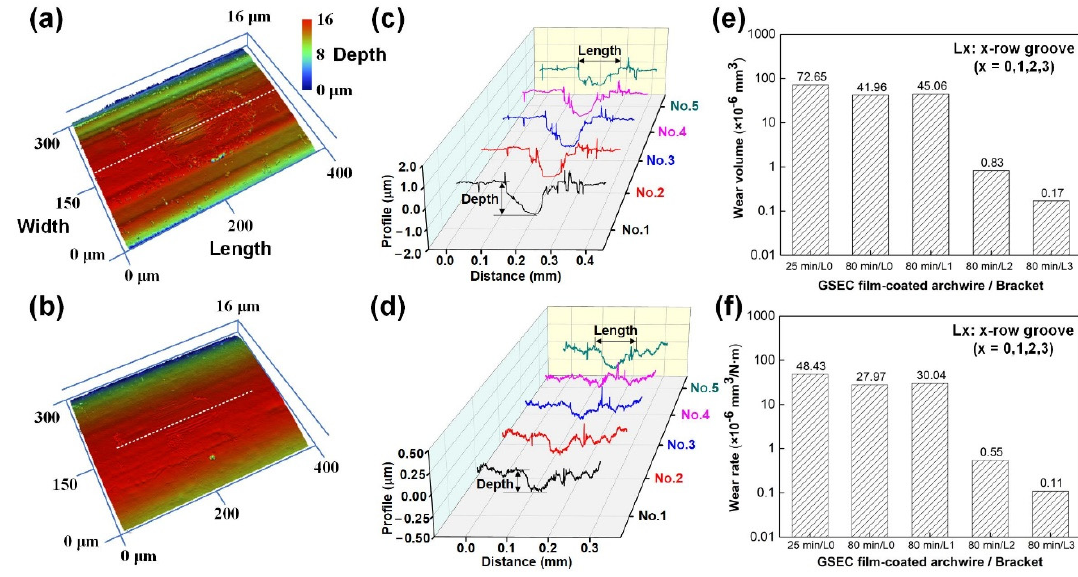
Figure 8. Calculation of the specific wear rate of GSEC film-coated archwires after sliding against untextured and micro-groove textured brackets for 5000 fretting cycles (10,000 times) in artificial saliva environment. ( a ) 3D image and ( c ) 2D cross-sectional profile of the wear scar on the GSEC film (+50 V and 25 min) coated archwires after running against untextured (denoted as L0) bracket. ( b ) 3D image and ( d ) 2D cross-sectional profile of the wear scar on the GSEC film (+80 V and 25 min) coated archwire after running against three-row micro-groove (denoted as L3) textured bracket. Cross-sectional profiles were obtained at five different positions along the length direction (white dotted line) of the wear scar. Calculated ( e ) wear volume and ( f ) wear rate of the GSEC film-coated stainless steel archwires. The Y axes are in log scale.